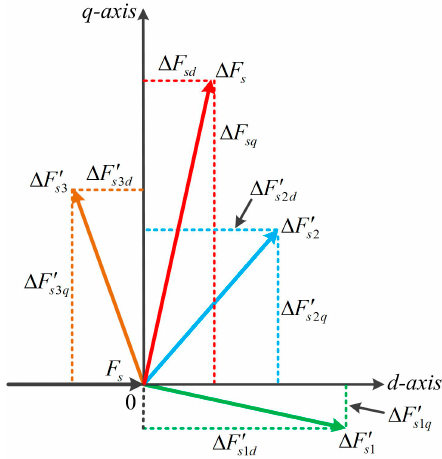
Figure 8. Analysis of error compensational effects provided by different active vectors.